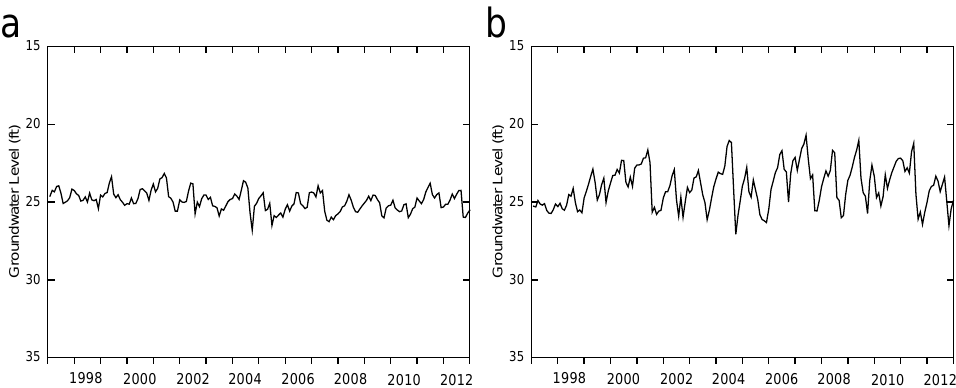
Figure 7. Plots of ( a ) groundwater level of M1255 ( b ) groundwater level of STL185. To eliminate the dimensional differences, the time-series data was normalized using the